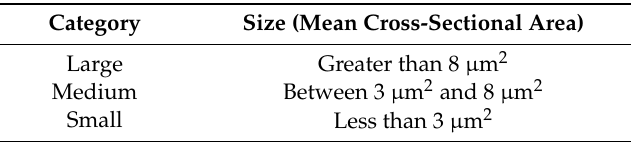
Figure 4. M reduces the formation of IBs. ( A ) the effect of M on IB formation. HeLa cells were transfected with plasmids encoding N and P alone or together with increasing amounts of pCAGGS-HA-M (50, 125, 250, 500 ng). At 24 hpt, cells were fixed and stained with antibodies against Myc and HA and visualized via confocal microscopy as described in Material and Methods. DAPI was used to stain the nuclear; Scale bar, 10 µ m. ( B ) the quantifications of large, medium and small IBs relative to IBs of all sizes in M transfected cells. The cross-sectional areas of IBs in ( A ) were measured. Large, medium, and small IBs were quantified in at least 50 cells for each group. The graph shows the percentages of large, medium, and small IBs to IBs of all sizes. Values are means ± standard deviations (SD) from three experiments; Student’s t test: * p < 0.05. ( C ) M regulates IB formation in HPIV3-infected cells. HeLa cells were transfected with plasmid encoding M. At 24 hpt, cells were infected with HPIV3 HA-P . At 48 hpi, cells were fixed for immunofluorescence assay as described in ( A ); Scale bar, 10 µ m. ( D ) the effect of M mutant on the formation of IBs. HeLa cells were transfected with plasmids encoding N and P alone or together with M L302A or M L305A . At 24 hpt, cells were fixed for immunofluorescence assay as described in ( A ). The quantifications of large, medium and small IBs relative to IBs of all sizes were calculated as described in ( B ). Values are means ± standard deviations (SD) from three independent experiments. Student’s t test: * p < 0.05, ns = not significant. Scale bar, 10 µ m. “+” means with transfecting corresponding plasmids in ( A , C , D ). Table 2. Category of IB according to its